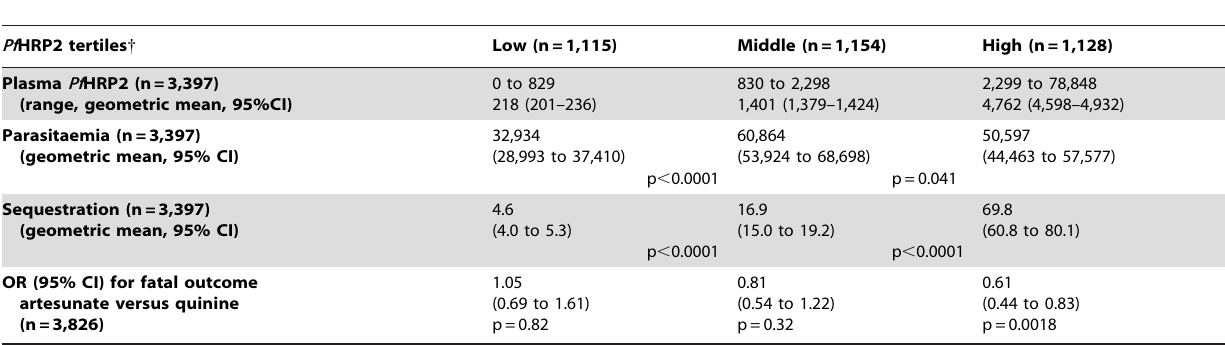
Table 3. Parasite density, Sequestration Index and Treatment effects of artesunate versus quinine according to Pf HRP2 tertiles.